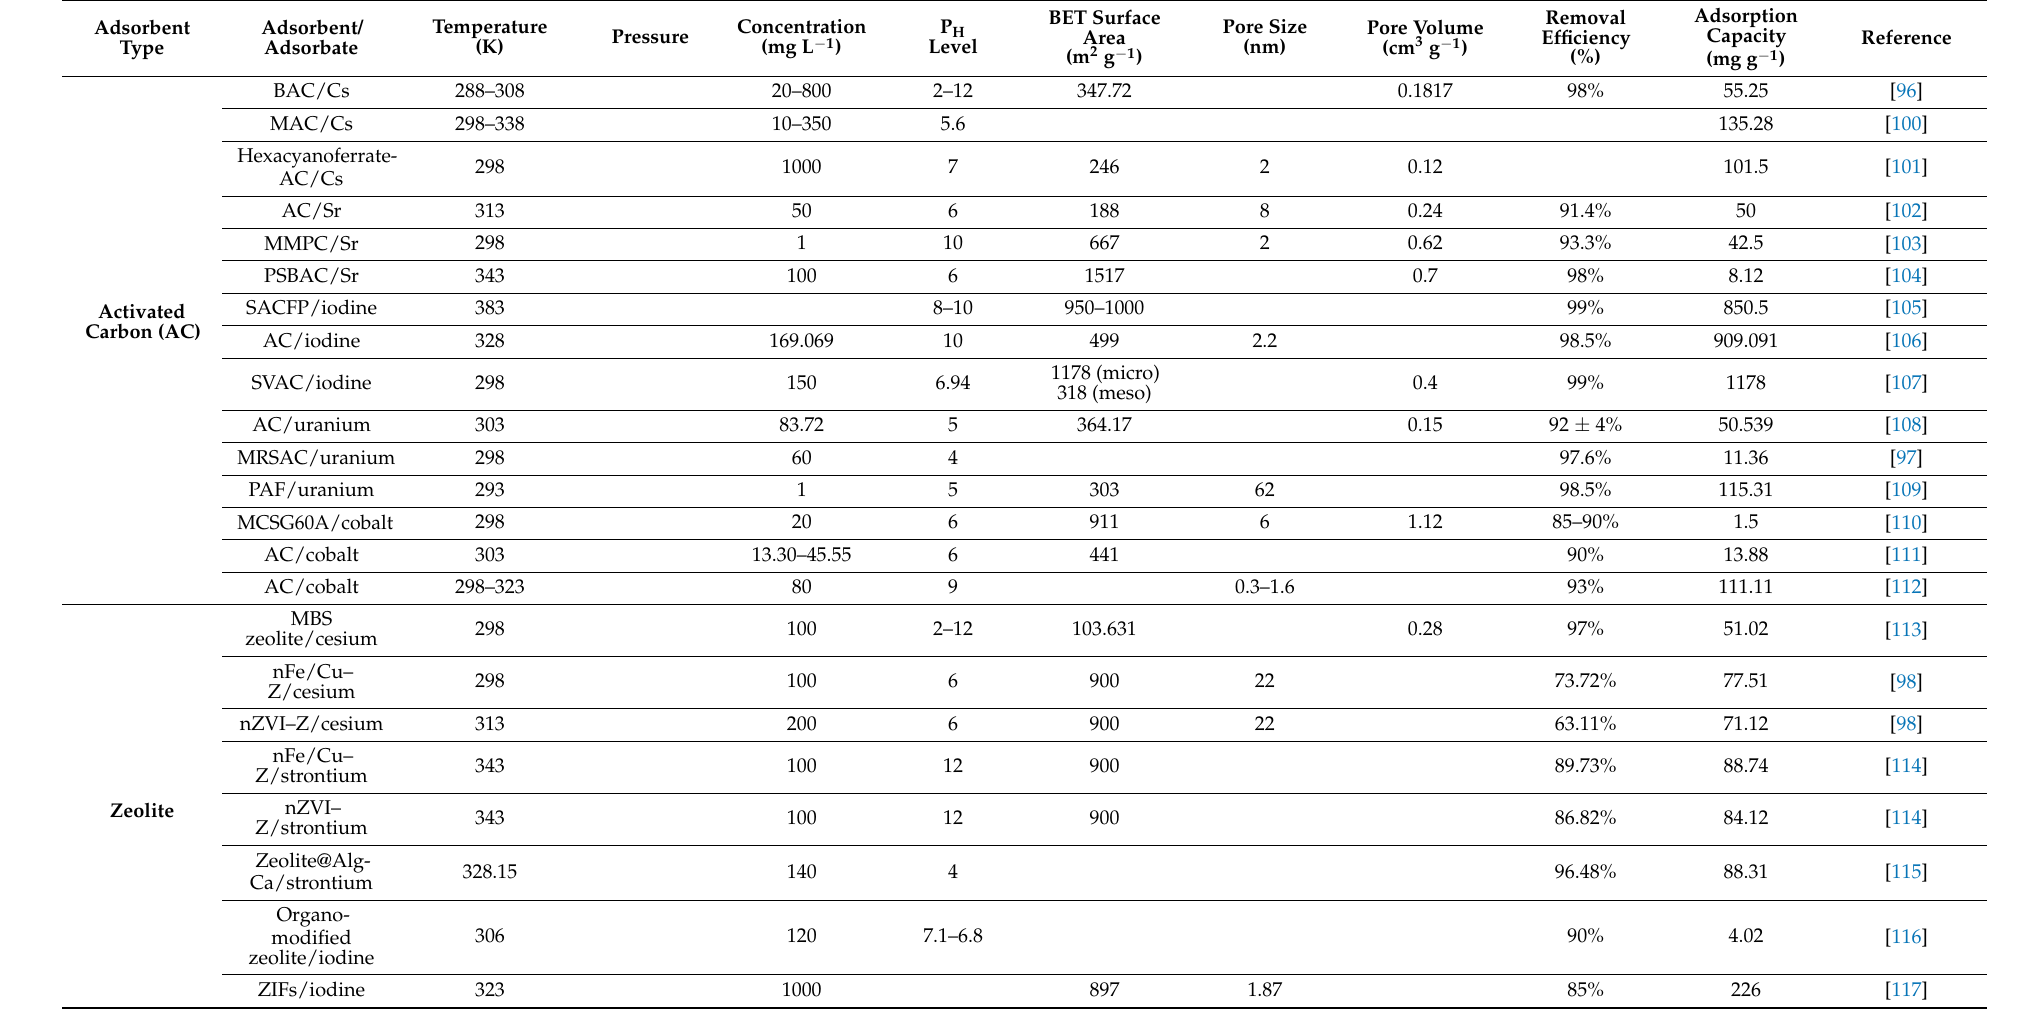
Table 4. Summary of experimental conditions, adsorption capacity and surface properties of different